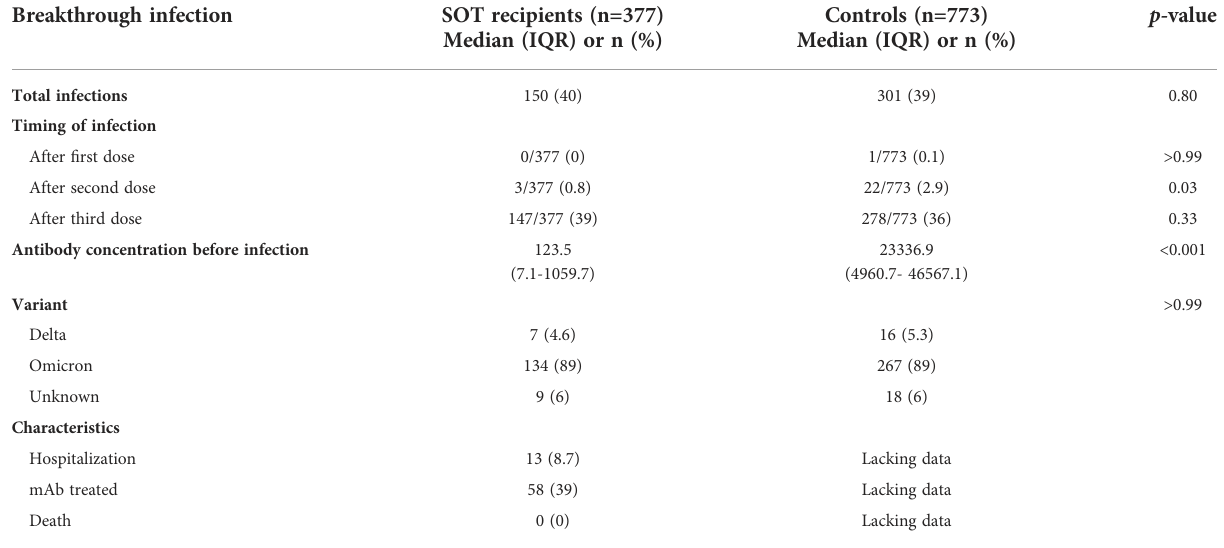
TABLE 3 Characteristics of breakthrough infections among solid organ transplant recipients and matched controls. Breakthrough